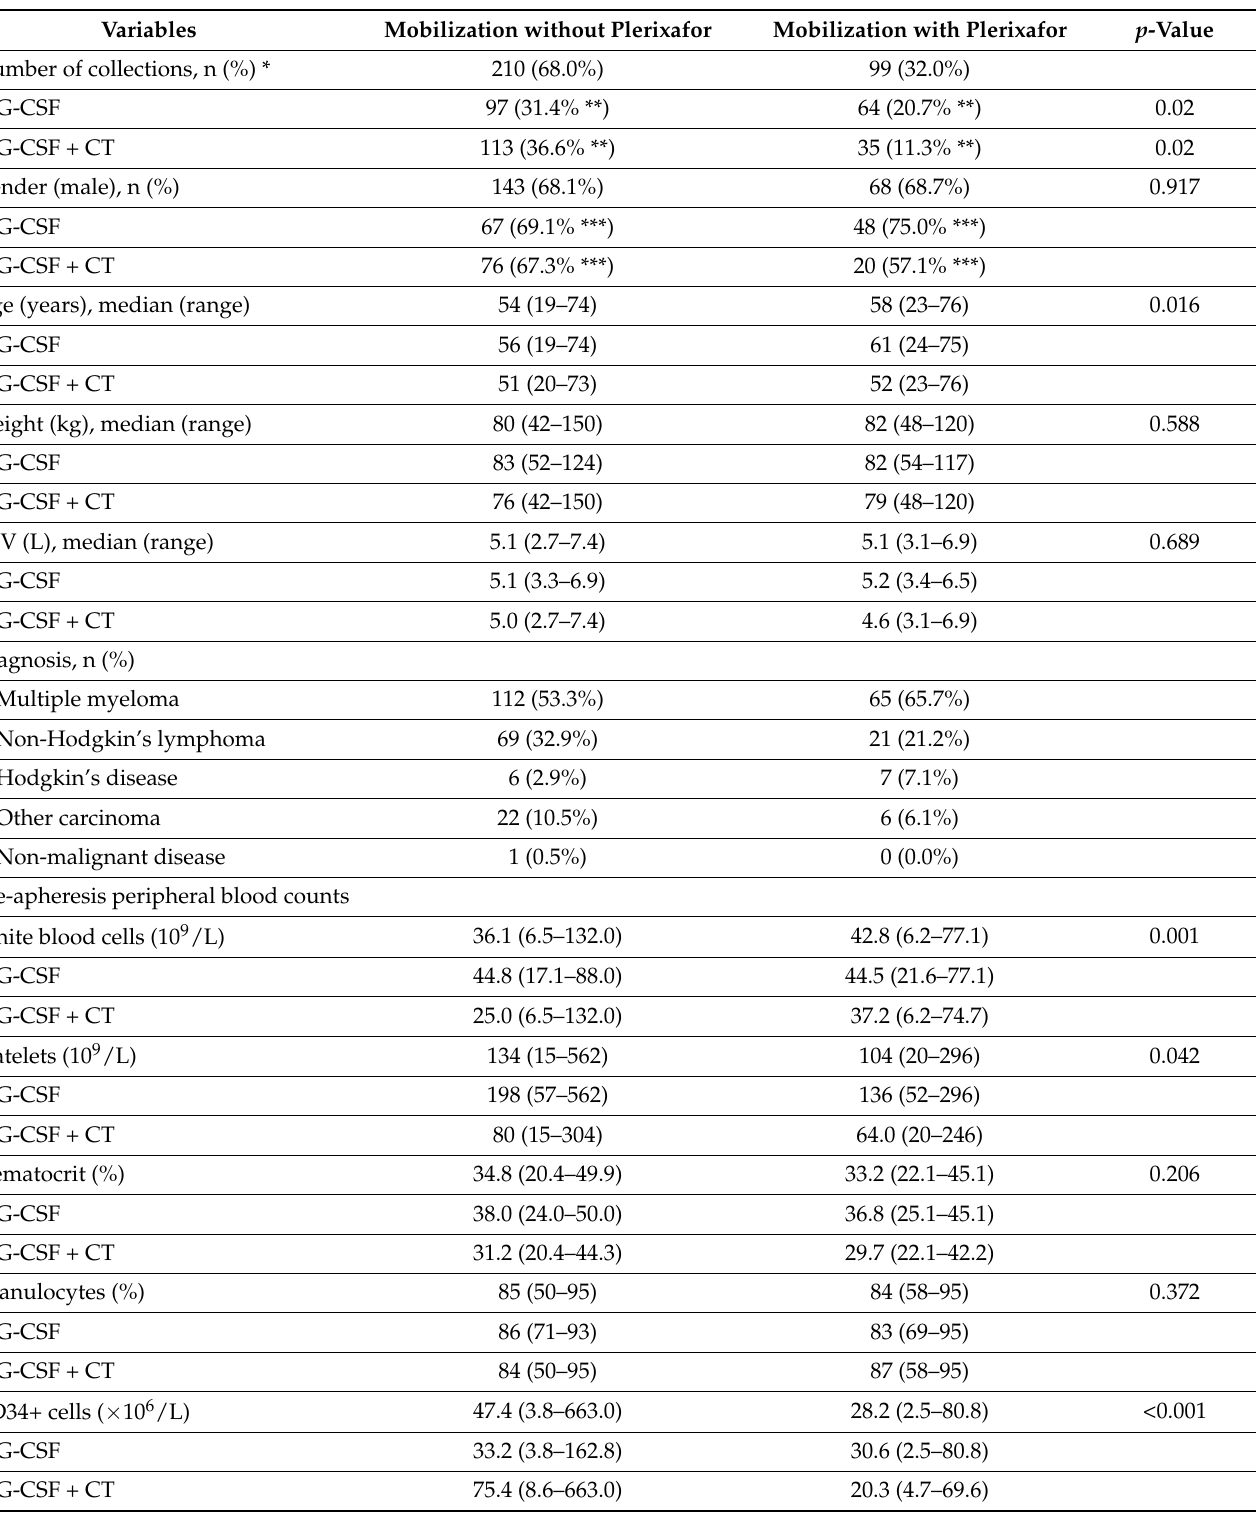
Table 1. Patient characteristics and pre-apheresis peripheral blood counts for the reviewed peripheral blood stem cell collection